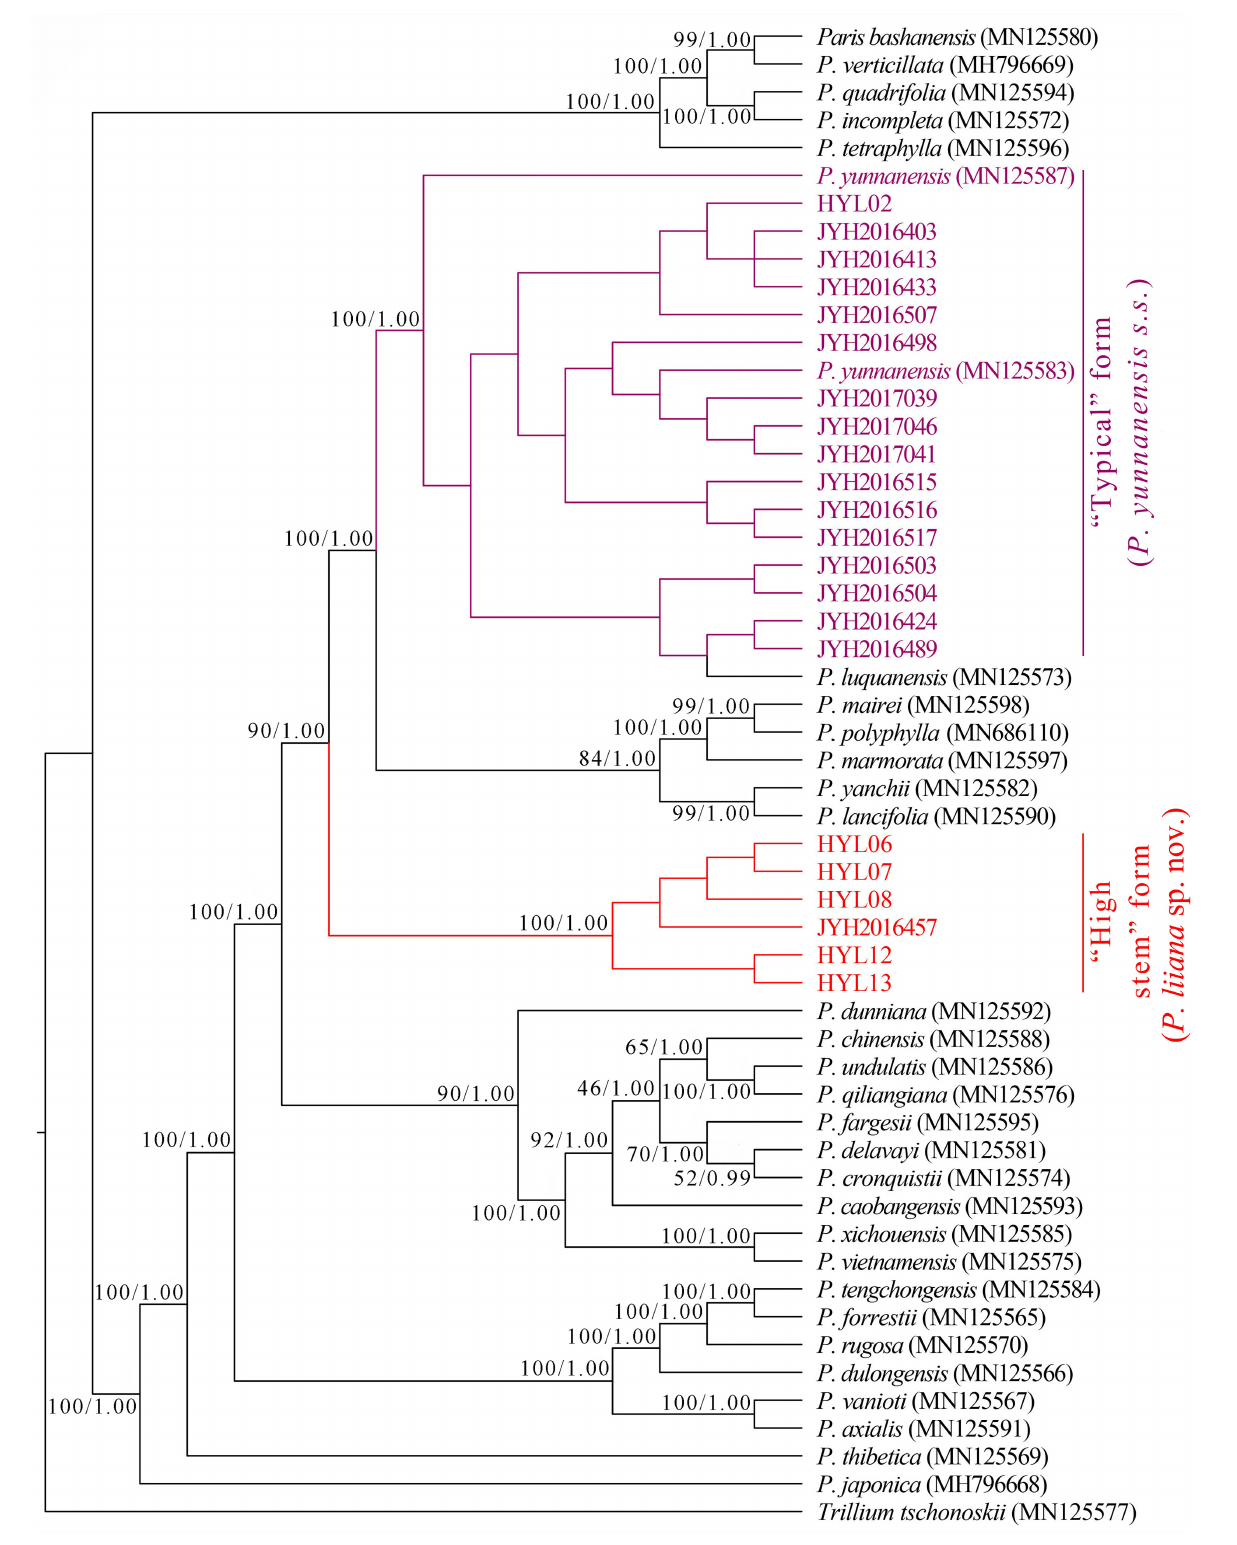
Frontiers in Plant Science |